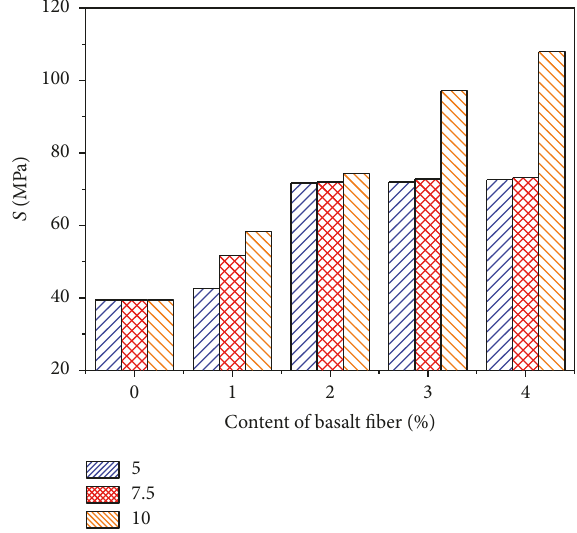
Figure 6: 𝑆 of asphalt mastics versus content.